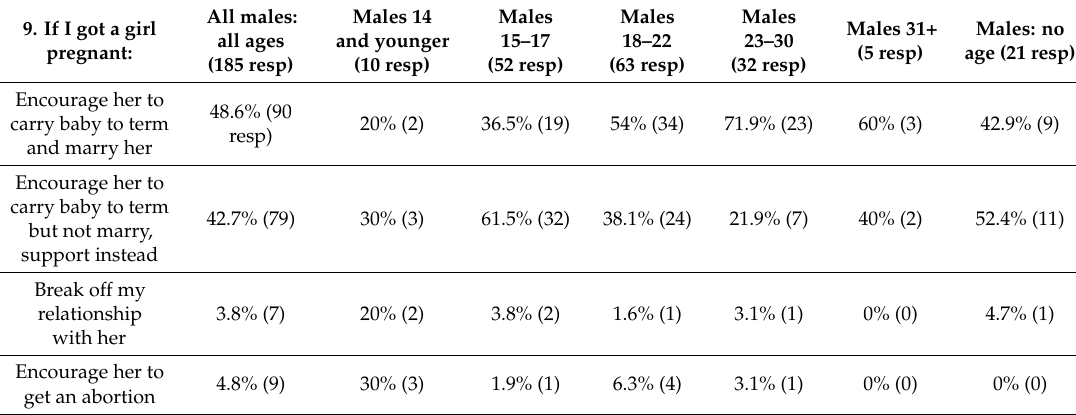
Table 15. Pregnancy Options—All